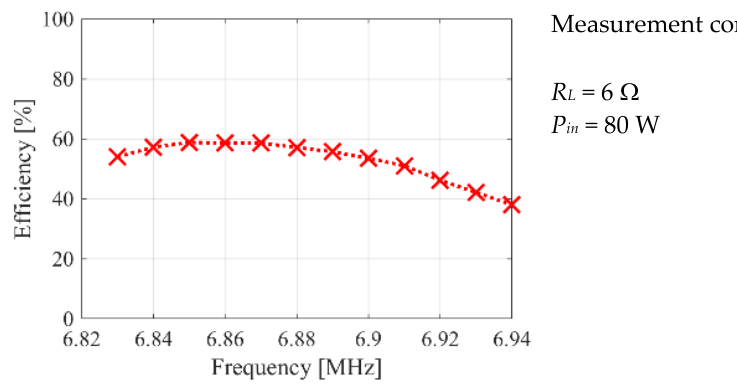
Energies 2019 , 12 , x FOR PEER REVIEW Figure 19. Efficiency dependent on distance. Figure 19. Efficiency dependent on distance.